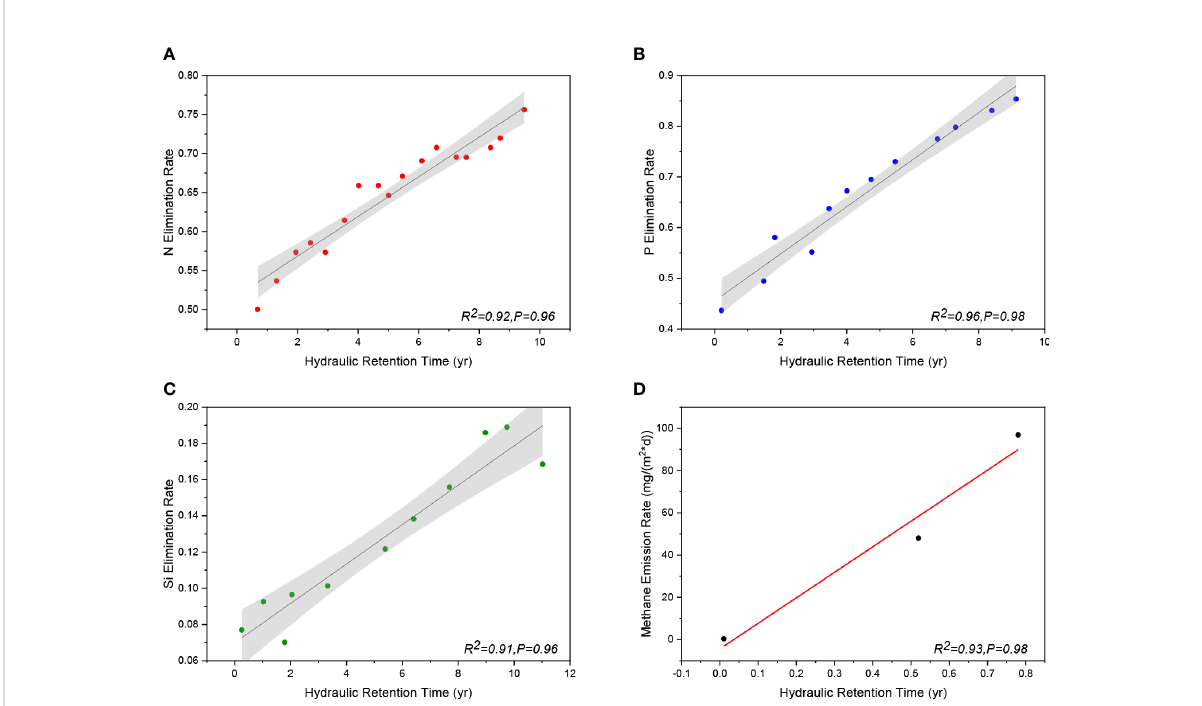
FIGURE 6 The graph names in order: (A) : Fitting curve of HRT and nitrogen removal ef fi ciency ( R 2 = 0.92, P = 0.96); (B) : Fitting curve of HRT and phosphorus removal ef fi ciency ( R 2 = 0.96, P = 0.98); (C) : Fitting curve of HRT and silicon removal ef fi ciency ( R 2 = 0.91, P = 0.96); (D) : Fitting curve of HRT and methane gas emission rate (water depth = 3m) (Data are from Li et al., 2018; Maavara et al.,